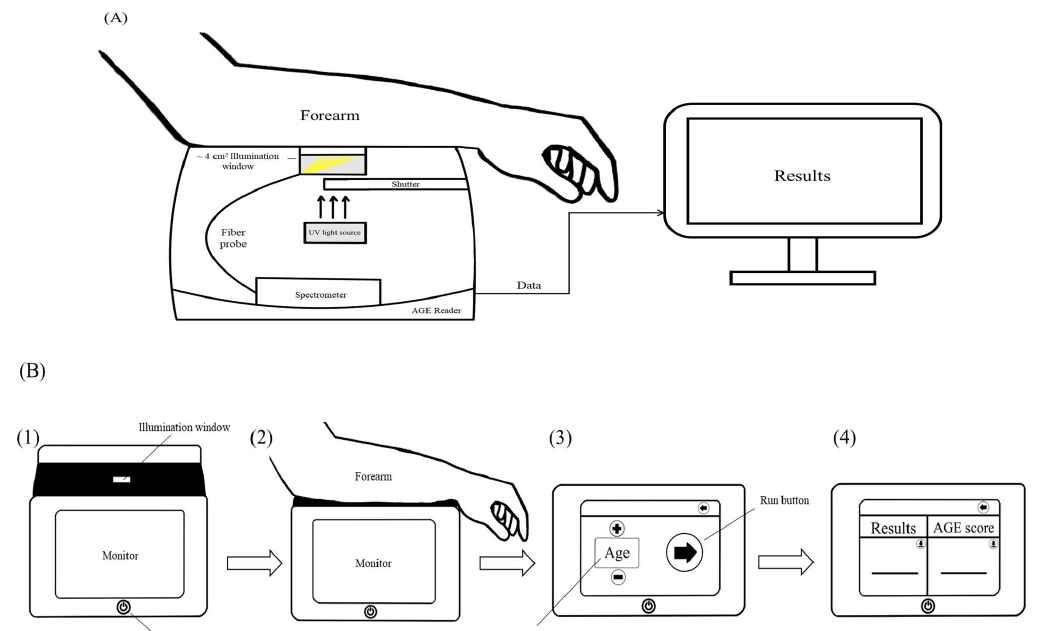
Figure 1. Description of the working principle and operating procedure of skin auto fluorescence (SAF) reader [184,185]. ( A ) Interior of a SAF reader is comprised of a scanner, an illumination